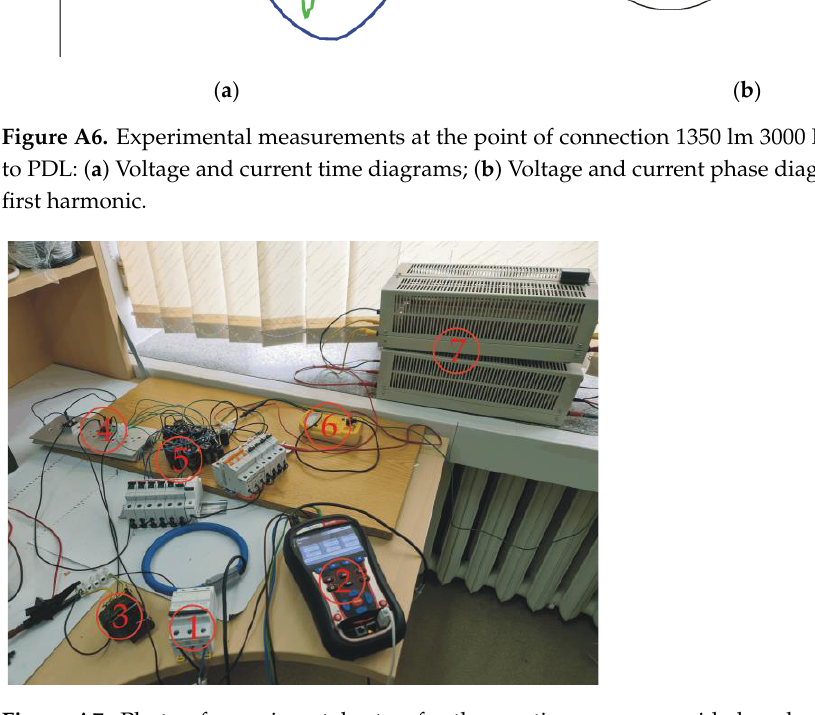
Figure A8. Photo of experimental setup for the reactive power provided or drawn out by LED light and diode rectifier supply-side devices analysis.